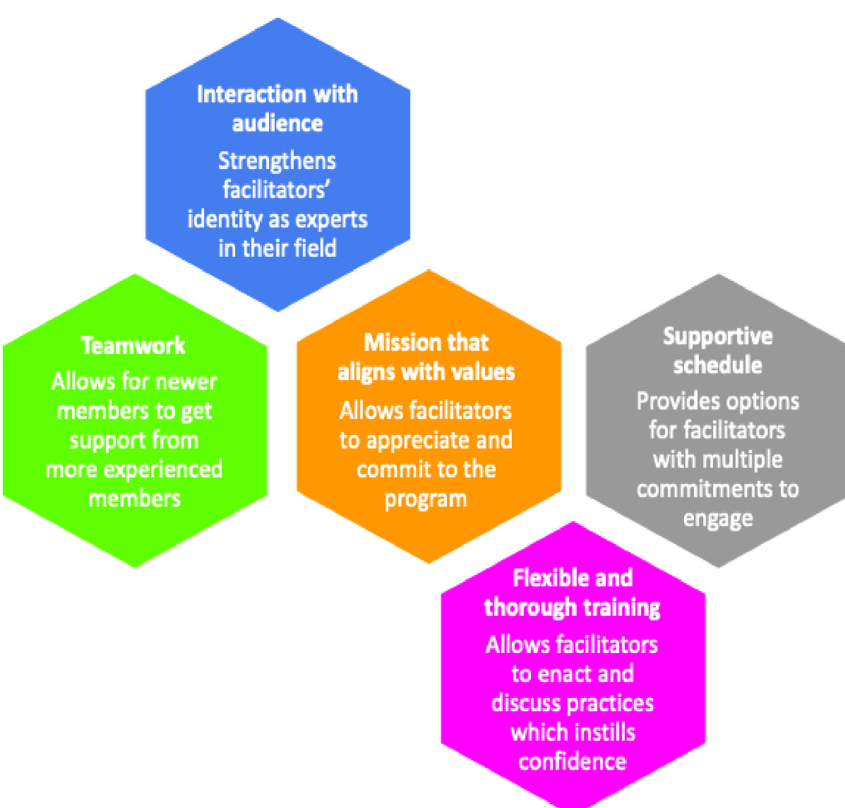
FIG. 7. Identified structures that support facilitators ’ identity based upon the interview analysis. These structures are general, and practitioners are encouraged to consider other program specific features. The color of each hexagon indicates the community dimension or mechanism of identity that each structure is connected to (e.g., teamwork is in green as it connects to mutuality of